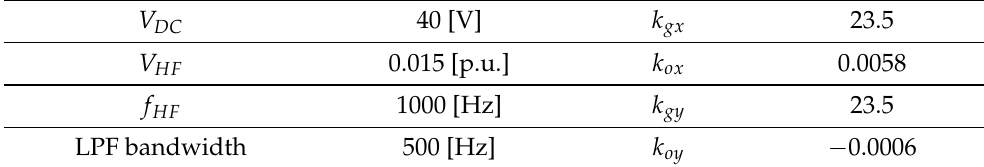
Table 4. xy self-bearing experimental conditions.